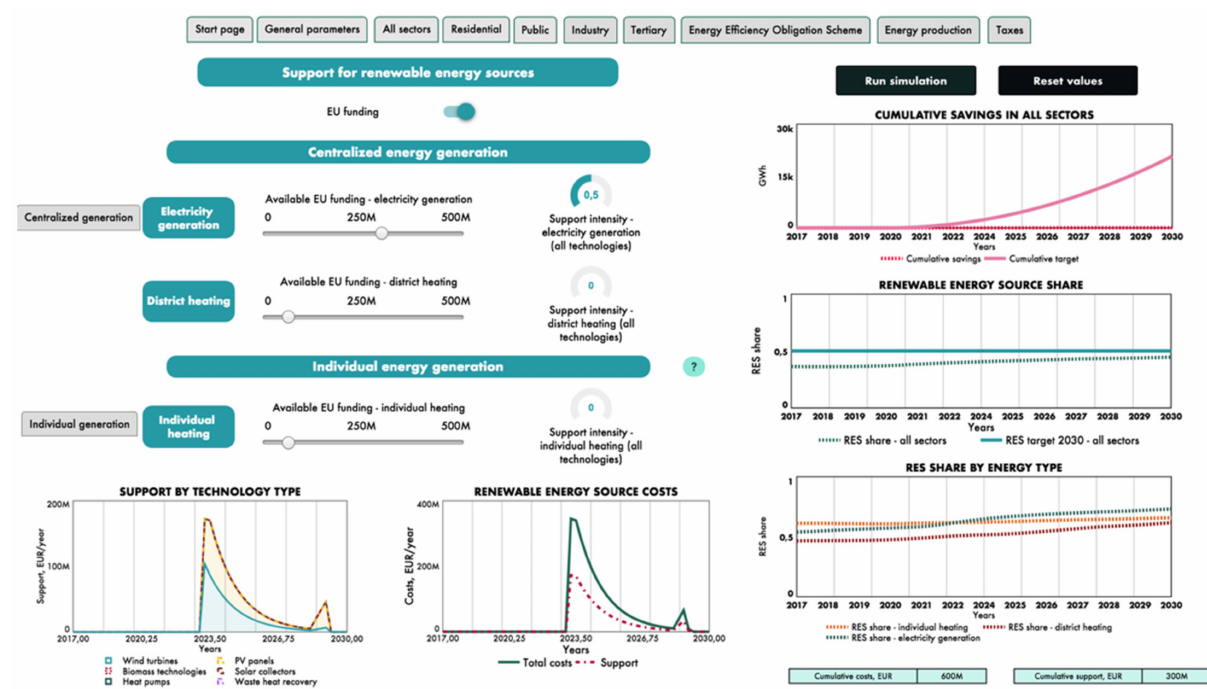
Figure A3. The summary page of Internet-based model interface for energy supply policy tools.